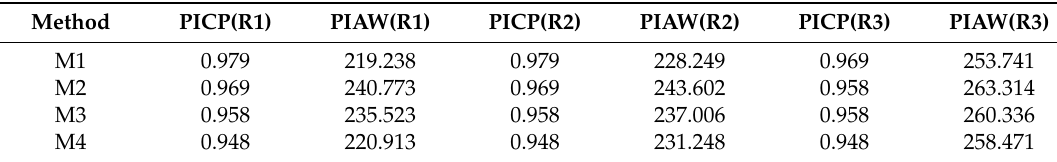
Table 4. Accuracy comparison between the four methods.